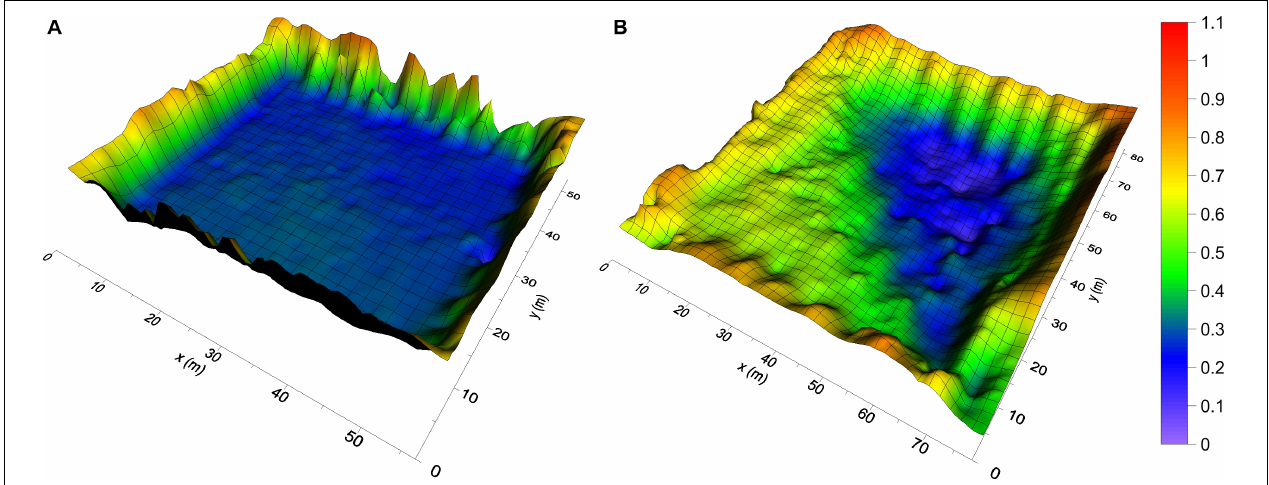
FIGURE 4 | Sludge profiles of test ponds. (A) Pond 1, inlet located at (52,48) and outlet at (1,44), has a reasonably uniform sludge distribution. (B) Pond 2, with inlet at (77,1) and outlet at (6,80), with a highly uneven sludge distribution, with a noticeable channel feature. The color scale indicates the height of the sludge-water interface (in meters) above the bottom of the pond.